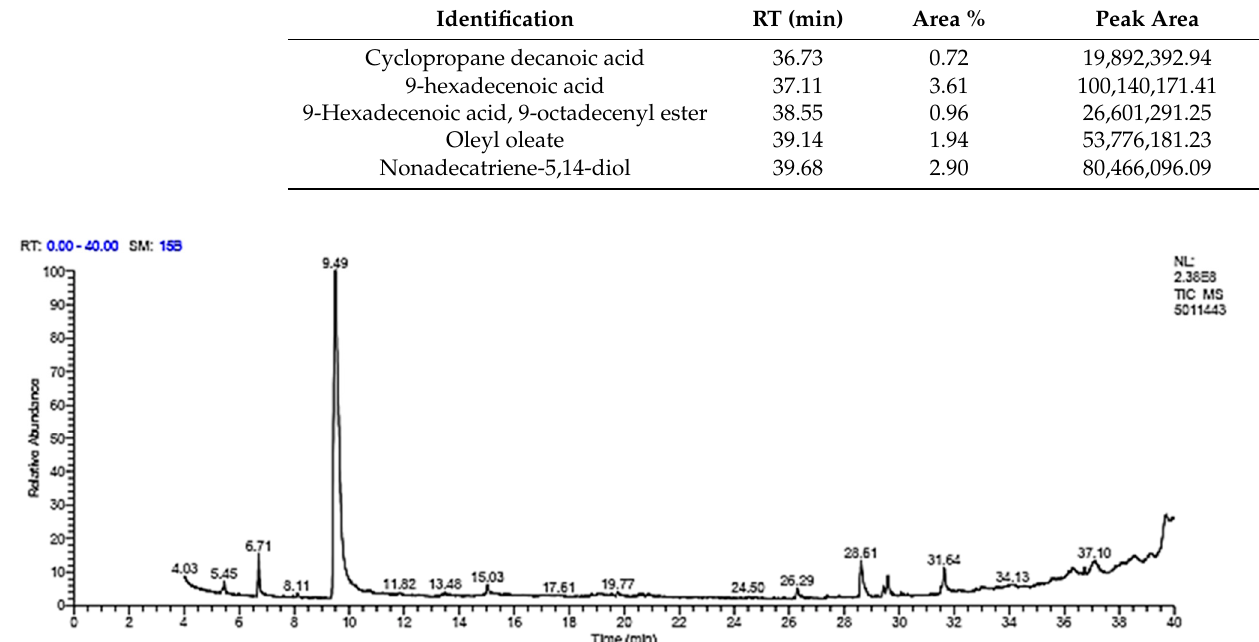
Figure 3. GC–MS spectrum of aniseed methanolic extract.